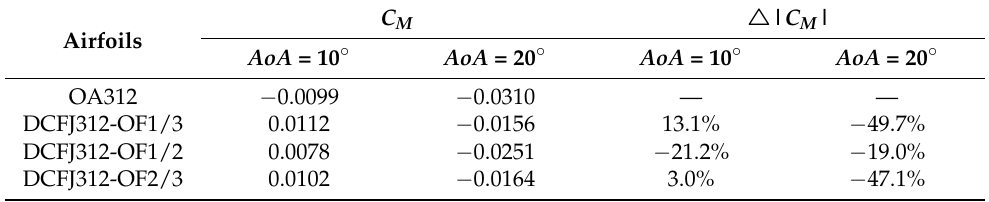
Table 10. Comparisons of moment coefficients of DCFJ312 airfoils with various OF s at typical AoA